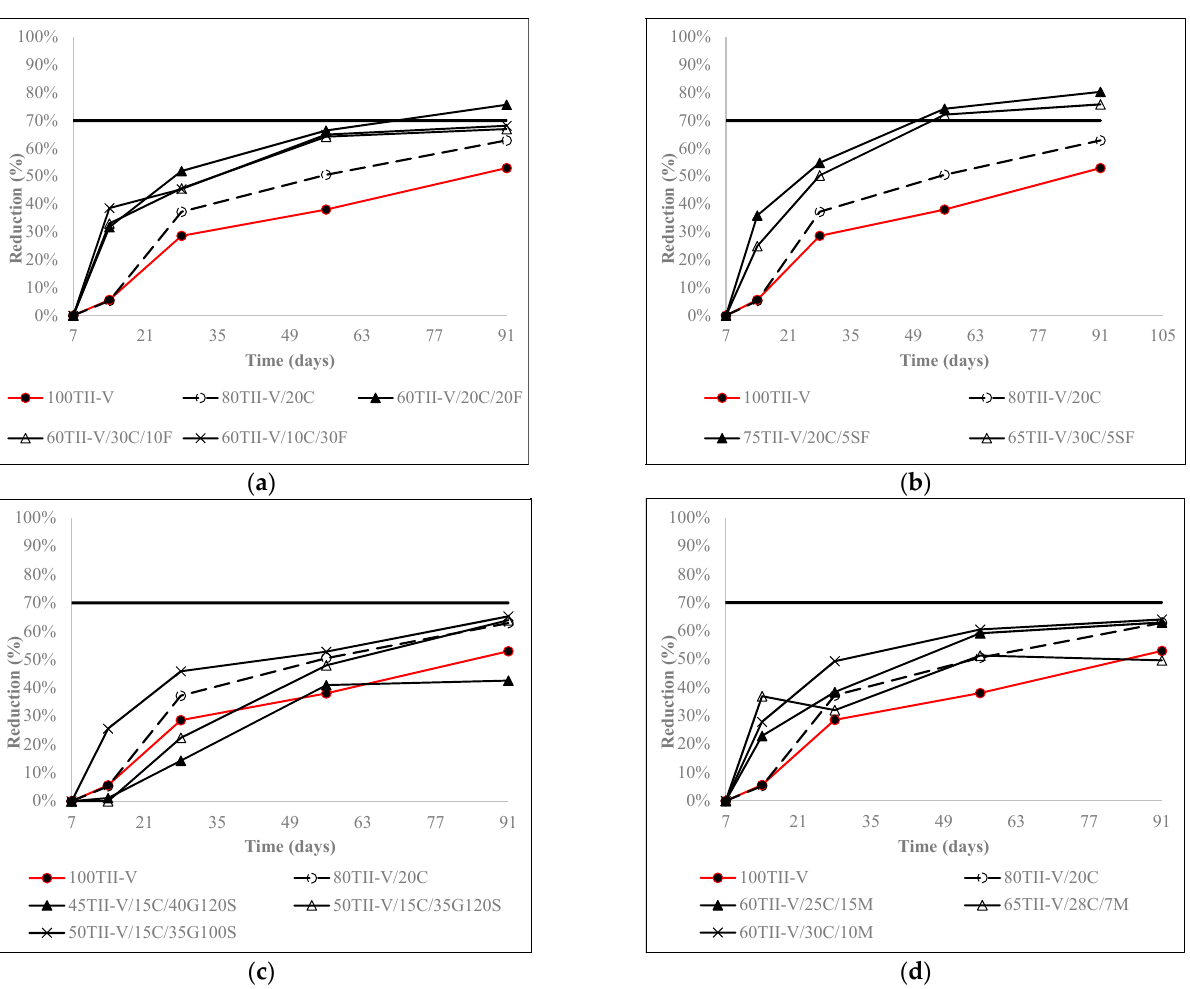
Figure 5. Influence of ( a ) Class F fly ash, ( b ) silica fume, ( c ) slag, and ( d ) metakaolin on the reduction of charge passed in Class C fly ash-based mixtures. The horizontal solid line represents the average reduction of charge passed for ternary mixtures at 91 days.